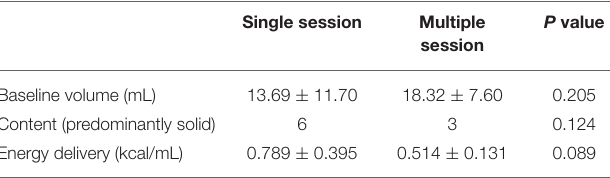
TABLE 2 | Comparison of potential factors affecting single and multiple session